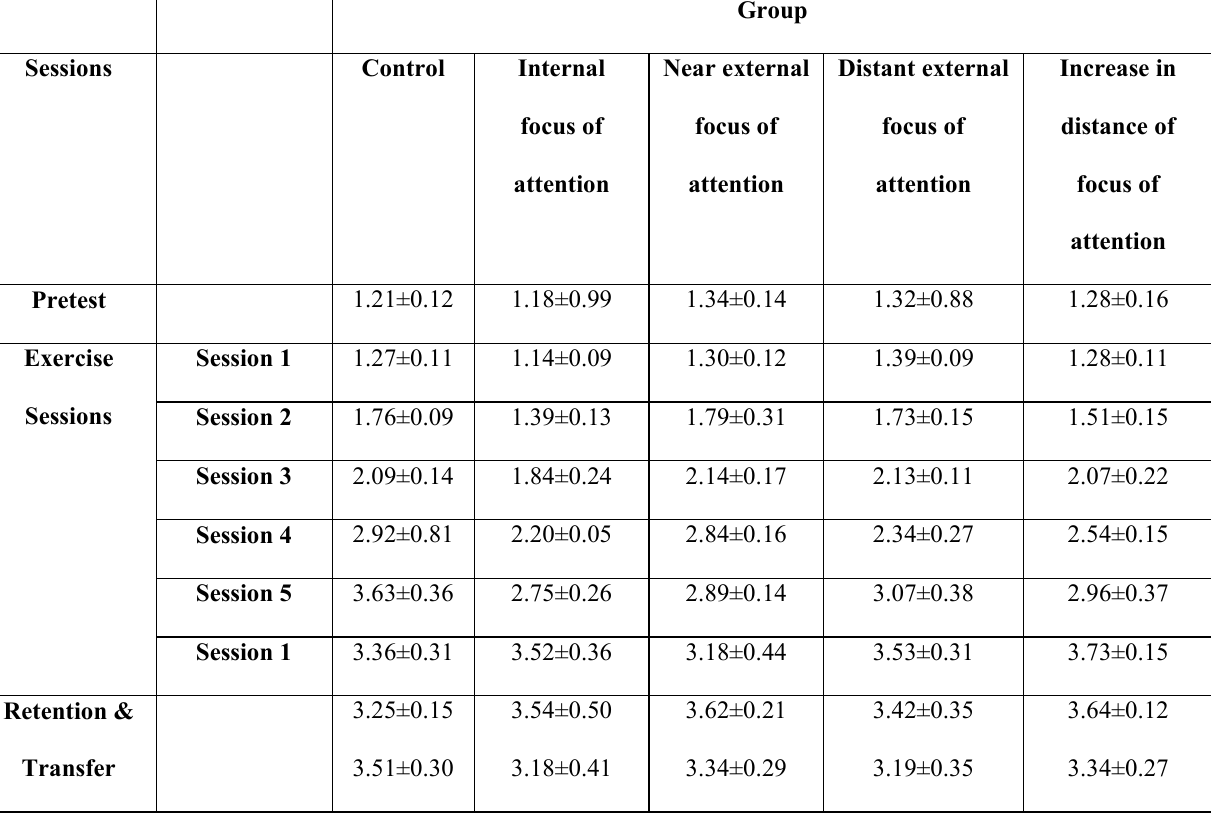
Backhand Movement Pattern of Treatment Groups in Six Exercise Sessions (M±SD)